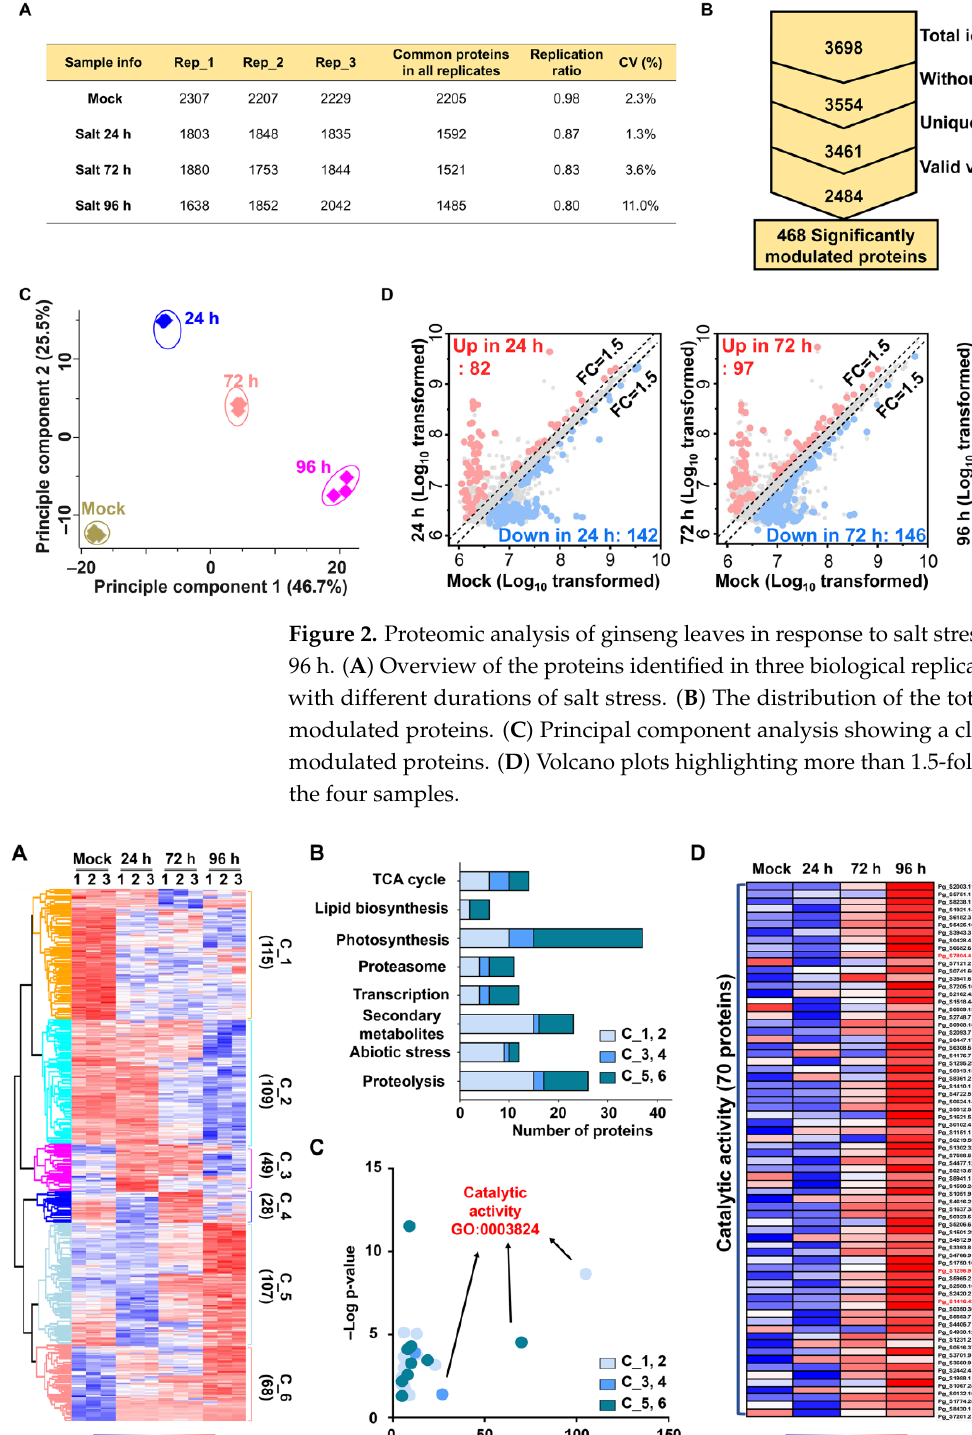
Figure 3. Multivariate analysis and functional classification of differentially modulated proteins (DMPs) in salt-treated ginseng leaves. ( A ) HCA grouped all 468 DMPs into 6 clusters based on their abundance patterns. ( B ) Functional overview of proteins classified into clusters using MapMan software. ( C ) GO enrichment analysis of proteins corresponding to their molecular functions in all clusters. ( D ) Heatmap showing the fold-change variation of each protein, corresponding to catalytic activity, and a box chart highlighting the 3 proteins predicted to have potential salt tolerance, with increased abundance in salt-treated ginseng